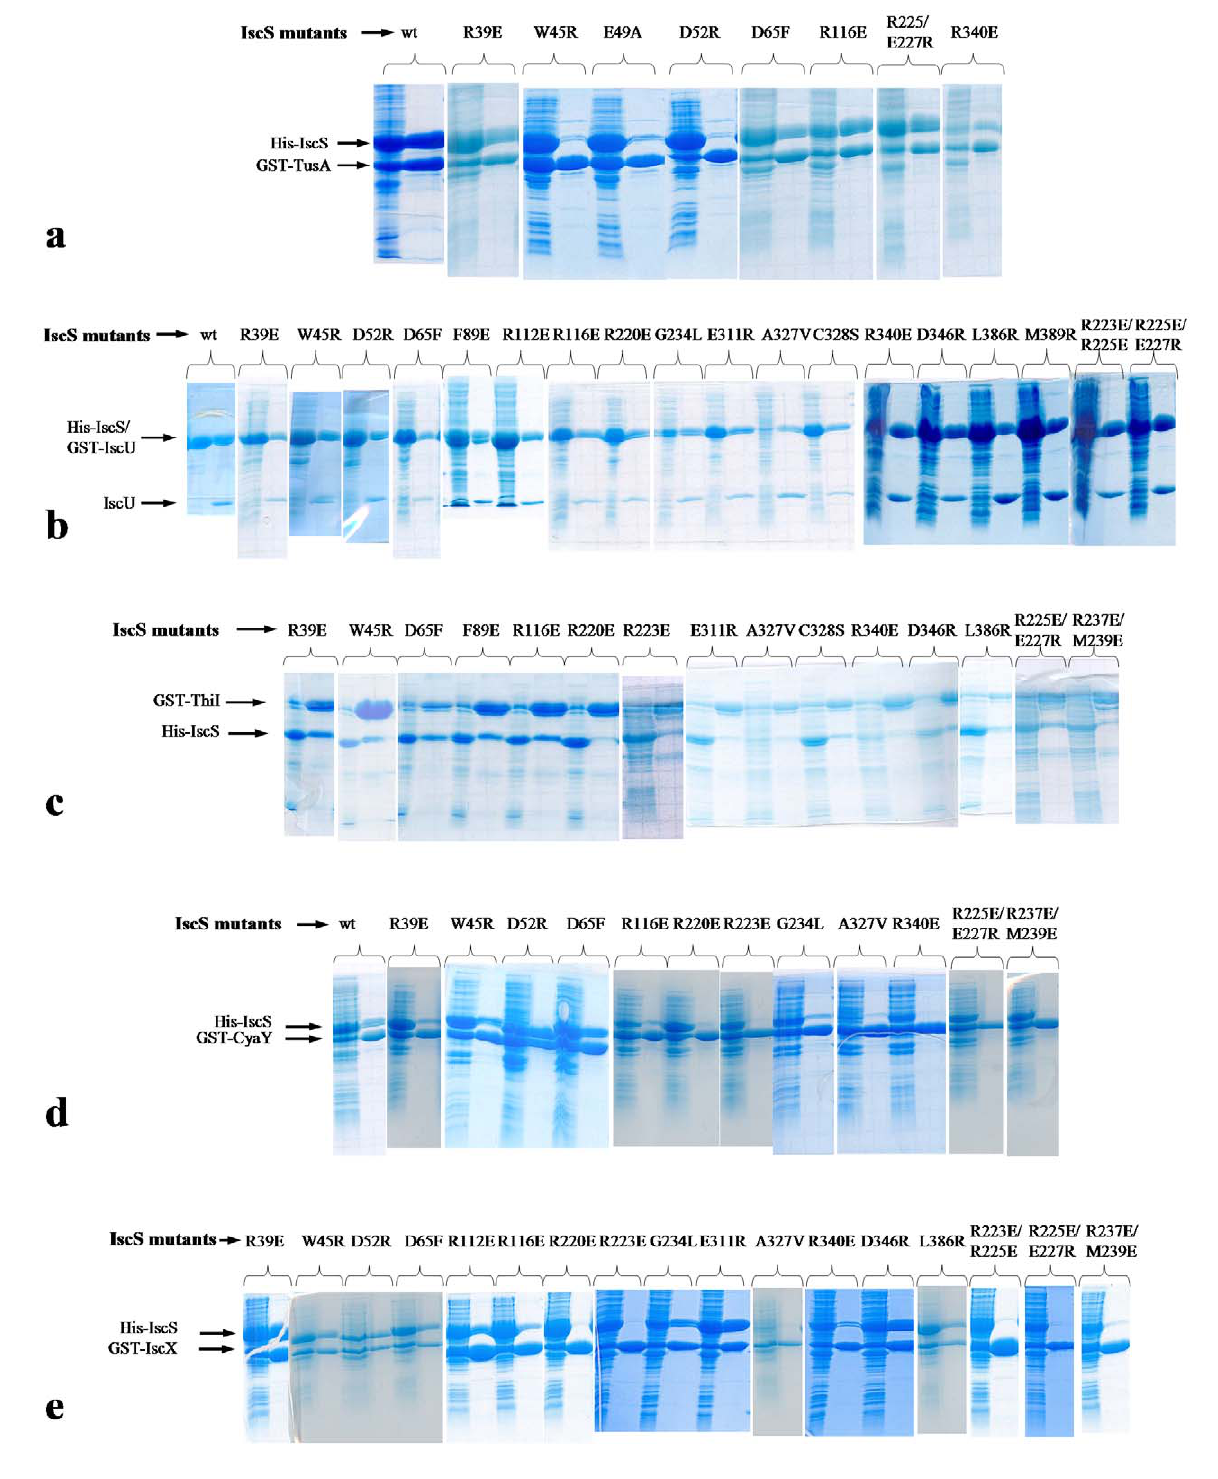
Figure 7. Interactions of IscS mutants with binding partners determined by in vitro pull-downs. Only interactions of representative mutants are shown. The IscS is His-tagged, the partners are GST-tagged, and the mixture was loaded on the glutathione Sepharose, the beads washed, and analyzed by SDS-PAGE. The mutations are indicated above the lanes. Two lanes are shown for each mutant: left shown the mixture loaded on the column; right, proteins retained on the column. (A) TusA; (B) IscU. His-IscS and Gst-IscU appear at the same place on the SDS gel (left lane). To distinguish between them the proteins were released from the beads by TEV protease cleavage of the GST and elution of His-IscS and untagged IscU. Only A327V show a small decrease in the IscS/IscU ratio; (C) ThiI; (D) CyaY; (E) IscX.